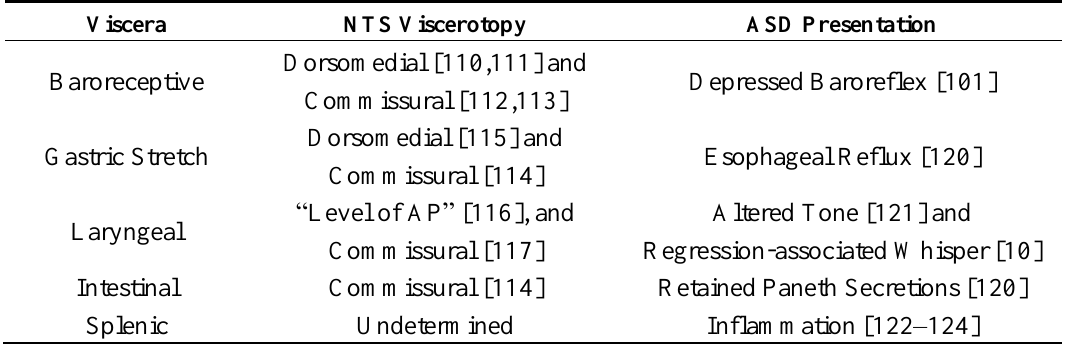
Table 1. Afferent Projections to pNTS and ASD